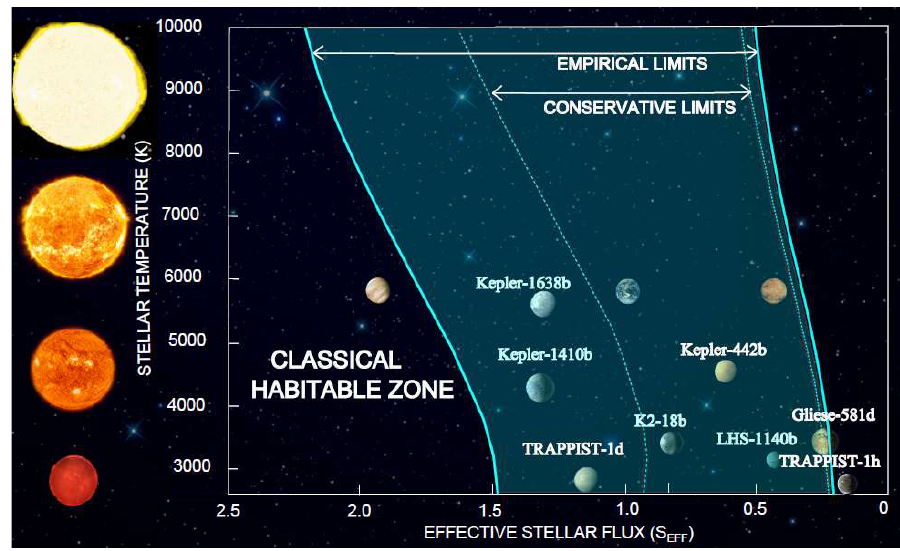
Figure 5. Extended classical habitable zone for stellar temperatures from 2600 to 10,000 K (based on work from Ramirez and Kaltenegger [2]). Table 1. Revised coefficients for the extended classical habitable zone (HZ) (atmospheric composition N 2 -CO 2 -H 2 O) and the empirical HZ for host stars with T EFF = 2600–10,000 K *. S EFF —effective stellar flux.